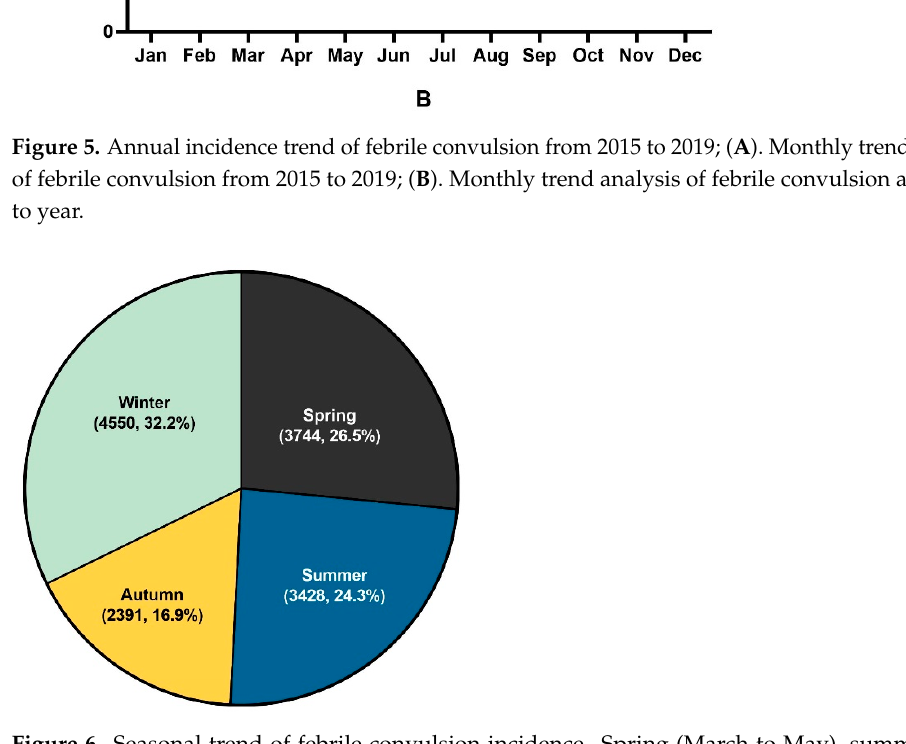
Figure 6. Seasonal trend of febrile convulsion incidence. Spring (March to May), summer (June to August), autumn (September to November) and winter (December to February). (Cumulative inci- dence for 5 years, %).